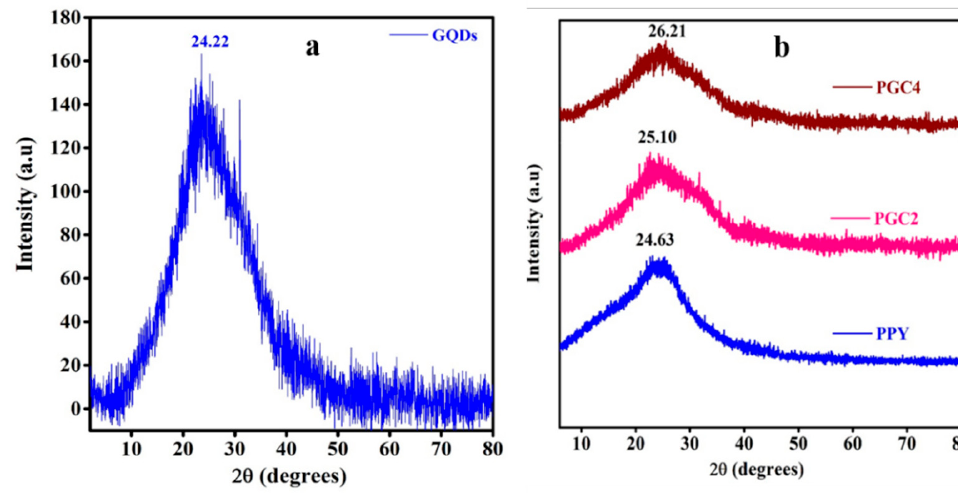
Figure 2. XRD study of ( a ) GQDs, ( b ) PPy, PGC2, and PGC4.